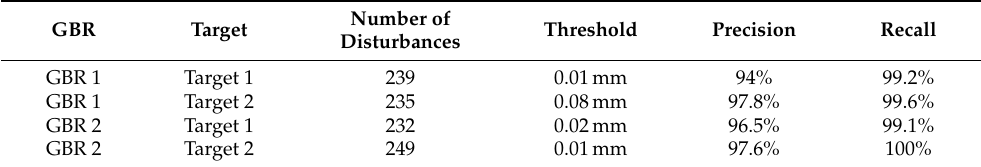
Table 1. Detection results for the displacement measurements in Schneckenlohe on 22 October